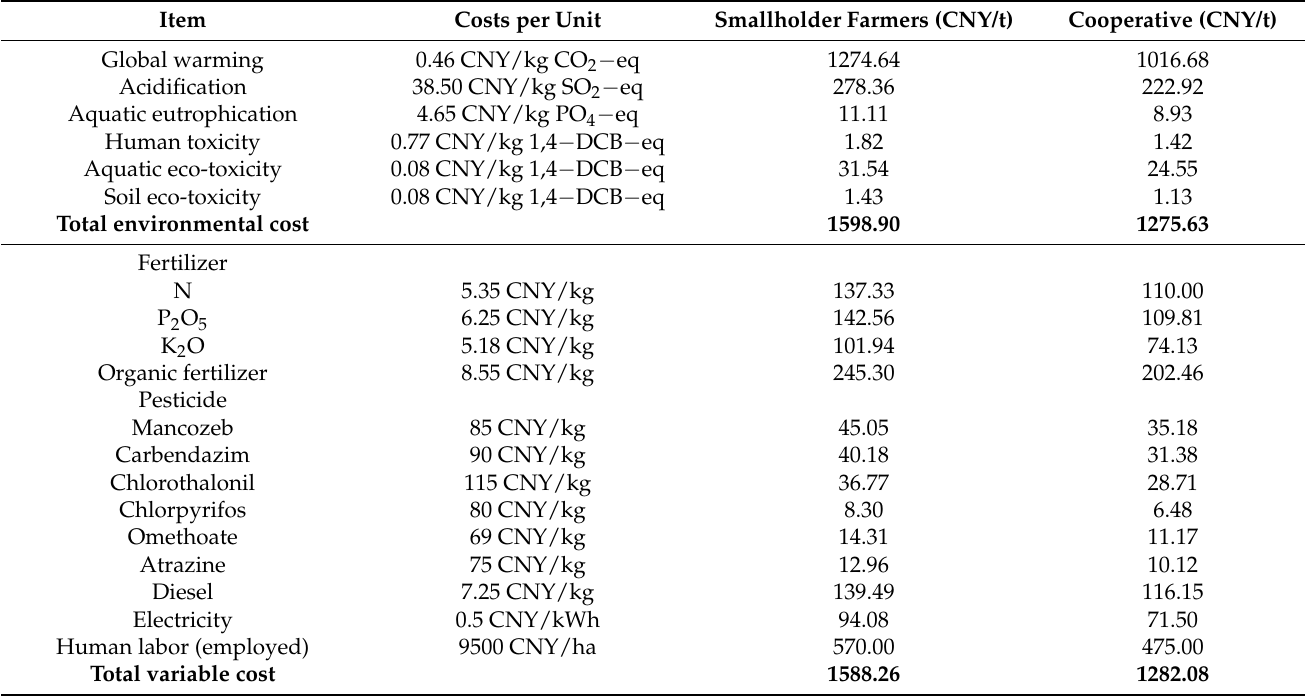
Table 7. Life cycle cost and net profit per ton of apple